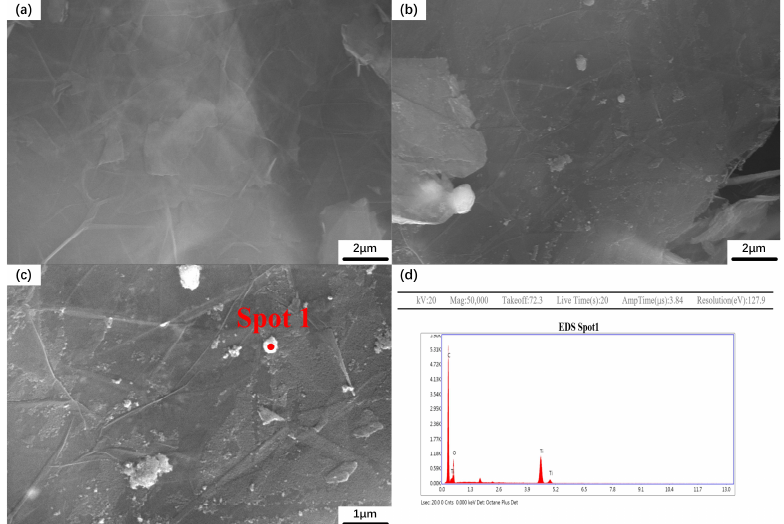
Figure 2. SEM images of ( a ) GNs, ( b ) TiO 2 /GNs composite, ( c ) partial enlarged drawing of ( b ), and ( d ) EDS report at red point in ( c ). Table 2. The relative content of different elements in the EDS report.